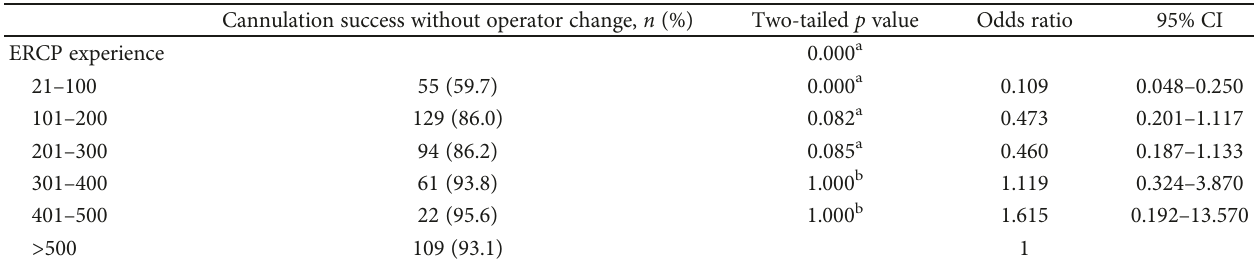
Table 5: The relationship between the ERCP experience and cannulation success rate without operator change. Cannulation success without operator change, n